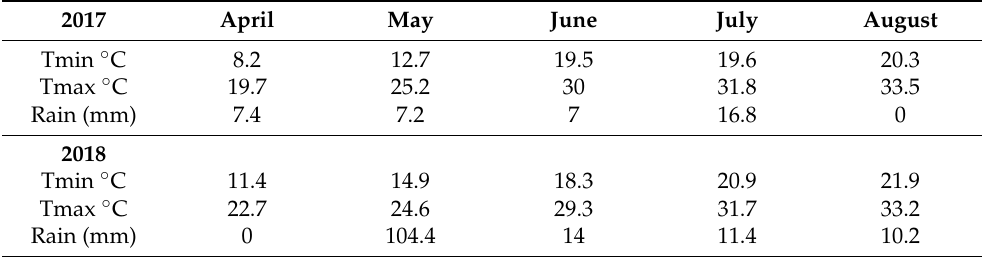
Table 3. Minimum and maximum temperature ( ◦ C), cumulated rain expressed as monthly means from April to August 2017 and 2018 in Grazzanise